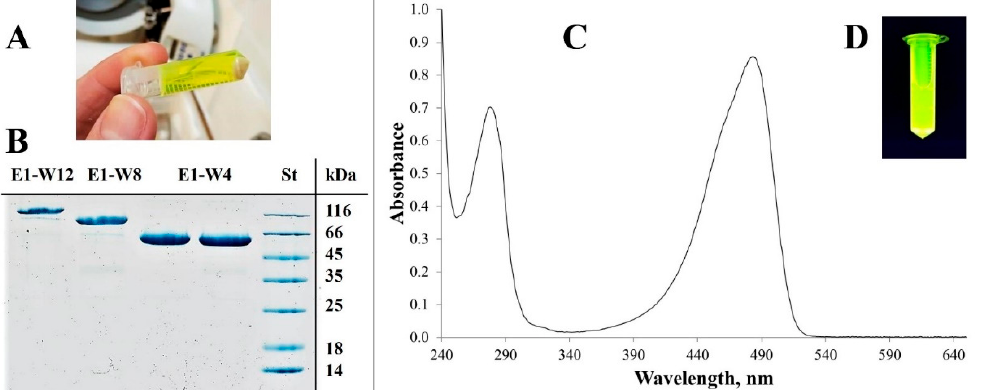
Figure 5. ( A ) E2-13W4 within a crude Escherichia coli lysate after sonication and subsequent centrifugation. ( B ) Analysis of the homogeneity of the purified MBS-proteins with 15% SDS-PAGE with subsequent staining of the gel with Coomassie brilliant blue R-250. ( C ) Absorption spectrum of the purified E2-13W4 protein (1.2 mg/mL) in 10 mM HEPES (pH 7.0). ( D ) The same solution of the E2-13W4 protein exposed to 314 nm ultraviolet light.